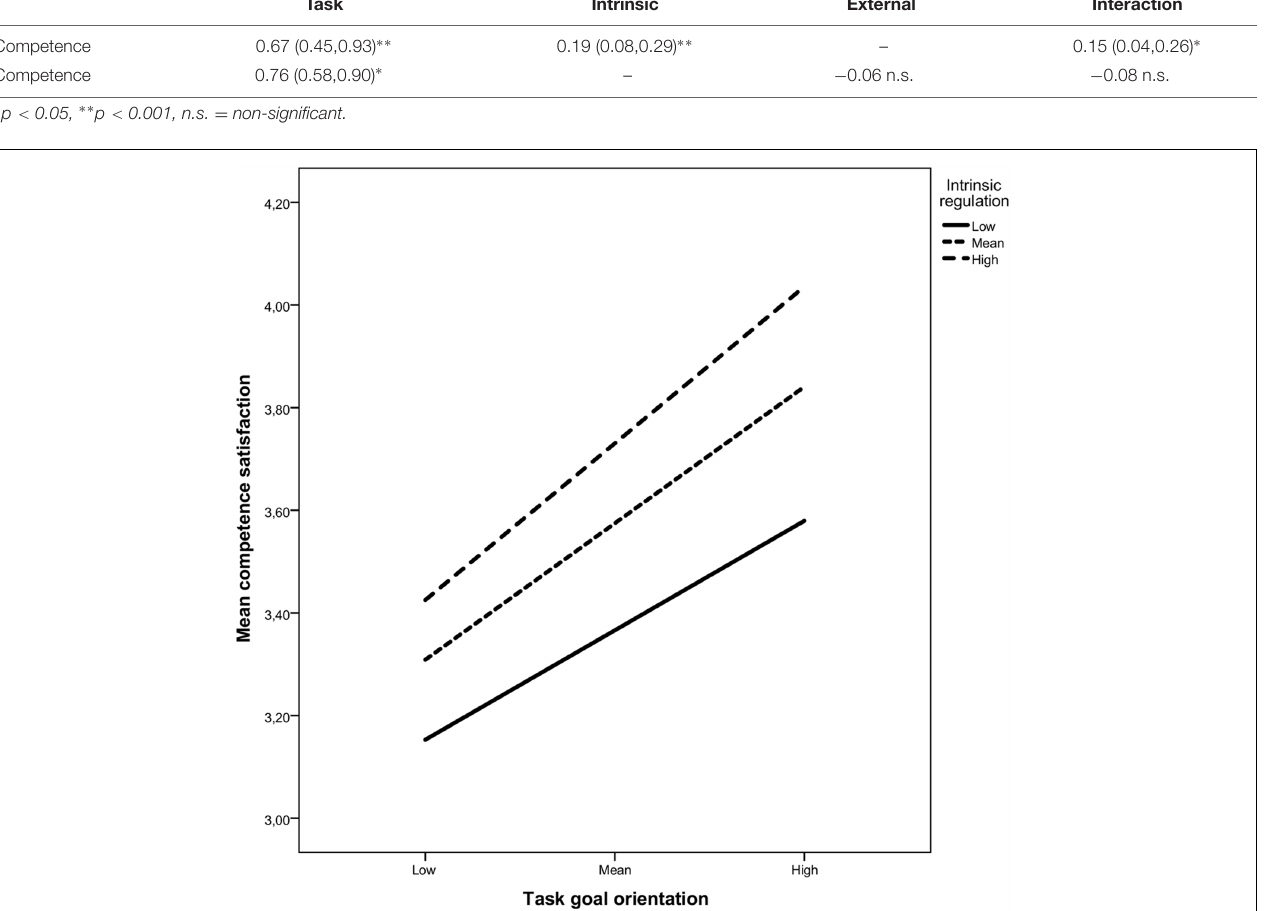
indirect effect of task goal on self-esteem through competence need emerged, significant at low (–1SD; B = 0.22, 95% CI BC :0.11,0.39), moderate (Mean; B = 0.29, 95% CI BC :0.16,0.47), and high levels of intrinsic regulation ( + 1SD; B = 0.35,